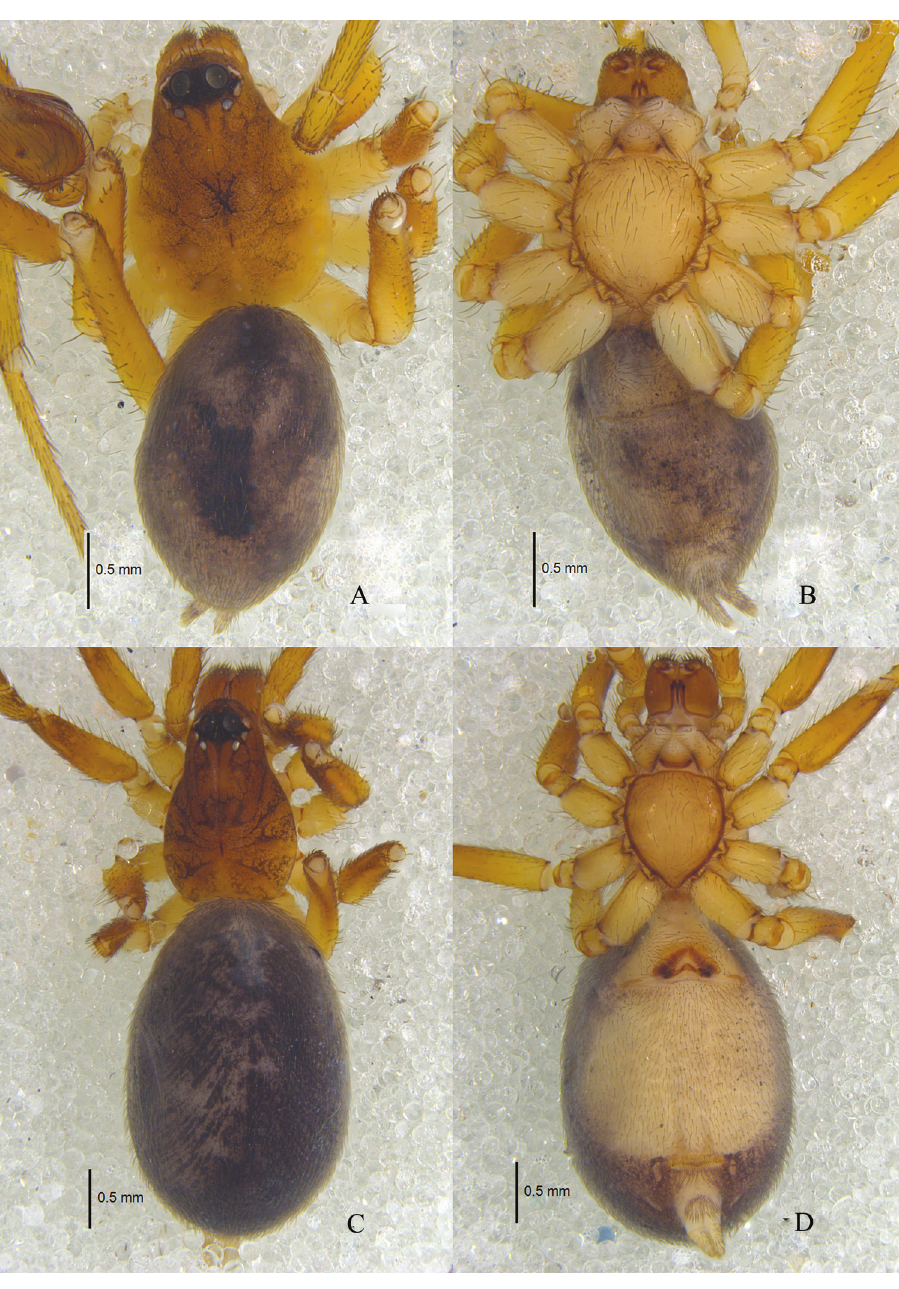
Figure 1. Zodarion apertum sp. n., habitus ( A, C dorsal view B, D ventral view) A, B Male holotype C, D Female